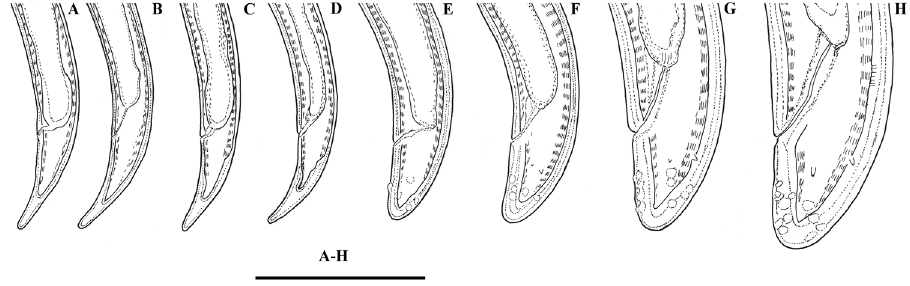
Figure 5. Enchodeloides signyensis (Loof, 1975), gen. n., comb. n. (= Enchodelus signyensis Loof, 1975). Juveniles (specimens from Livingston Island): A–D Tail ends (J1) E–G Tail ends (J2-J4) Female (specimen from Livingston Island) H Tail end . Scale bar: 50 µm.